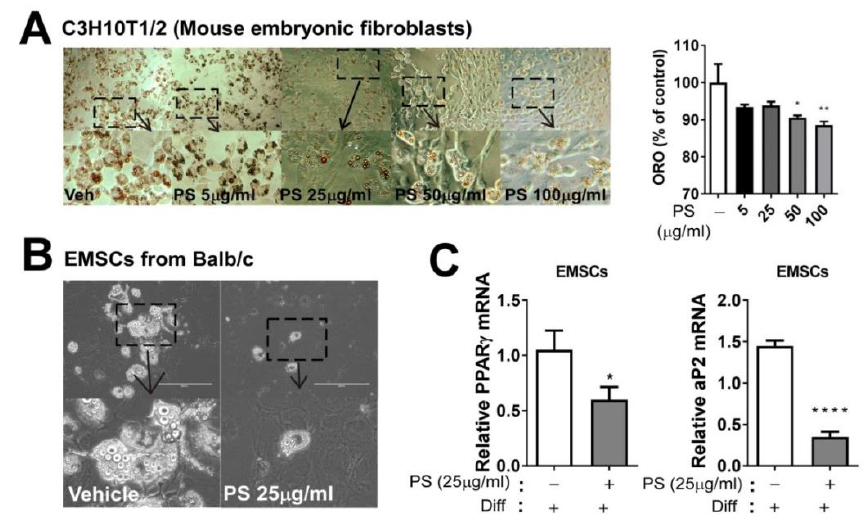
Figure 3. PSE inhibits adipogenesis in C3H10T1/2 mouse embryonic fibroblasts, adipocytes, and EMSCs. C3H10T1/2 cells were seeded and induced to differentiation in the presence of either DMSO (vehicle control) and PSE (5–100 µ g/mL) for four days: ( A ) Triglyceride accumulation was visualized by Oil red-O staining and representative images from three separate experiments are shown in ( left ) (magnified 4 × ); extracted ORO staining was quantified (OD 500 nm) ( right ). Primary adipocytes were prepared from EMSC of Balb/c mice: ( B ) Phase contrast images of primary adipocytes were differentiated with or without PSE (25 µ g/mL) for seven days (magnified 4 × , scale bar = 400 µ m); ( C ) adipogenic gene expression of PPAR γ and aP2 by qPCR. * p < 0.05; ** p < 0.01; **** p < 0.0001 compared with the vehicle control (DMSO treated cells) by one-way ANOVA with Bonferroni’s comparison test or Student’s t-test. +; treatment, -; non-treatment.